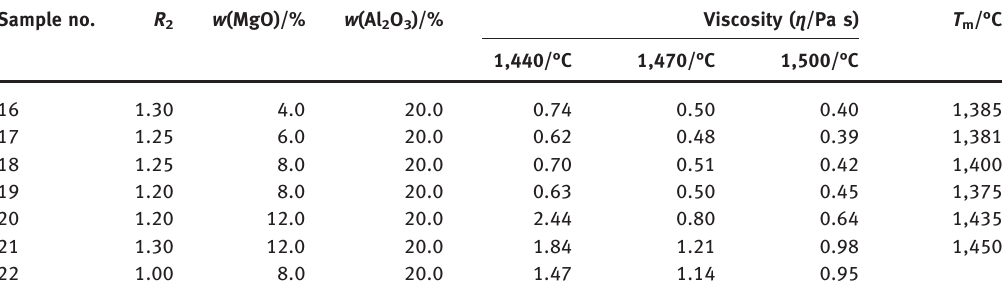
Table 2: Effect of MgO on the viscosity of slag. Sample